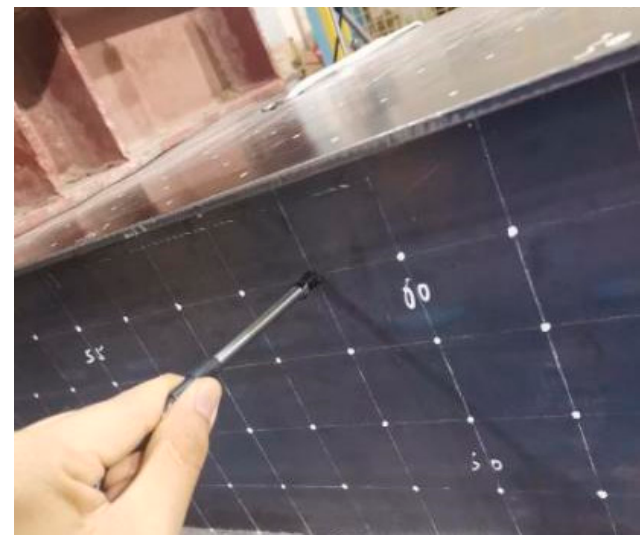
Figure 8. Pen probe inspection.